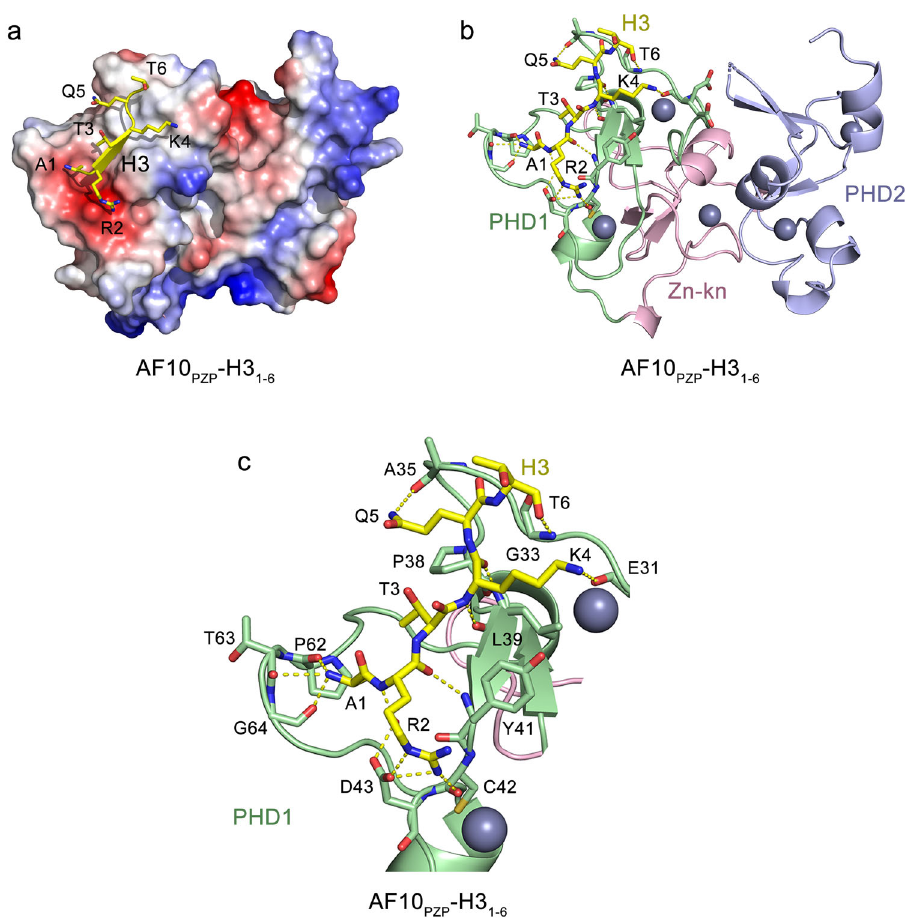
Fig. 4 Structural basis for the recognition of H31-6 by AF10 PZP . a Electrostatic surface potential of AF10 PZP in the complex, with blue and red colors representing positive and negative charges, respectively. The H3 tail (only Ala1-Thr6 of H3 are shown for clarity) is yellow. b The crystal structure of the H3-bound AF10 PZP is shown as a ribbon diagram with PHD1, Zn-knuckle, and PHD2 colored light green, pink, and light blue, respectively. The Ala1-Thr6 region of H3 is depicted as yellow sticks. The zinc ions and waters are shown as gray and red spheres, respectively. Yellow dashed lines indicate hydrogen bonds. c Close-up view of the histone H3 1-6 binding site of AF10 PZP